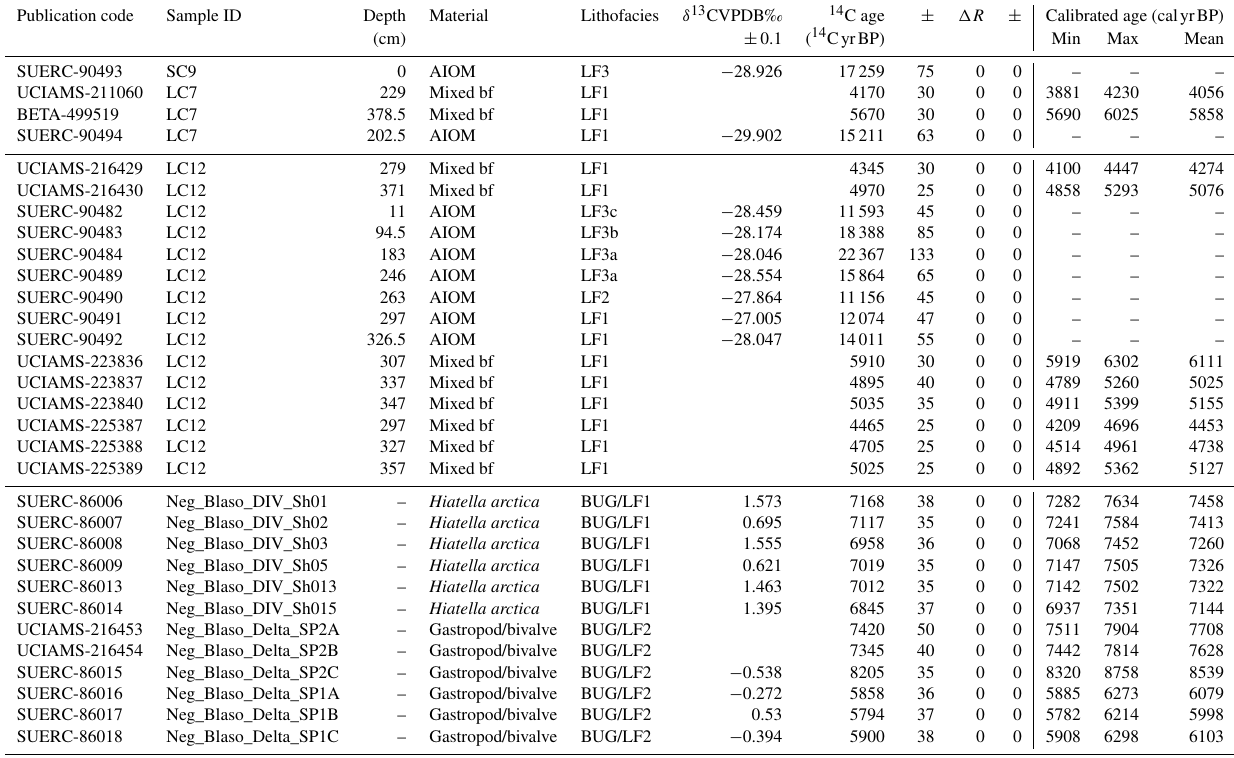
Table 2. Compilation of radiocarbon ( 14 C) ages for cores LC7 and LC12 and uplifted glaciomarine sediments. “bf” refers to benthic and “AIOM” denotes acid-insoluble organic matter. All 14 C ages were corrected using a marine reservoir effect (MRE) of ∼ 550 years ( (cid:49)R of 0 ± 0 years), following Hansen et al. (2022). Corrected 14 C ages were calibrated with the CALIB Radiocarbon Calibration program (version 8.1.0; http://calib.org/calib/, last access: 16 January 2023) using the Marine20 calibration curve (Heaton et al., 2020). Calibrated ages are given as a 2 σ range (min, max, and